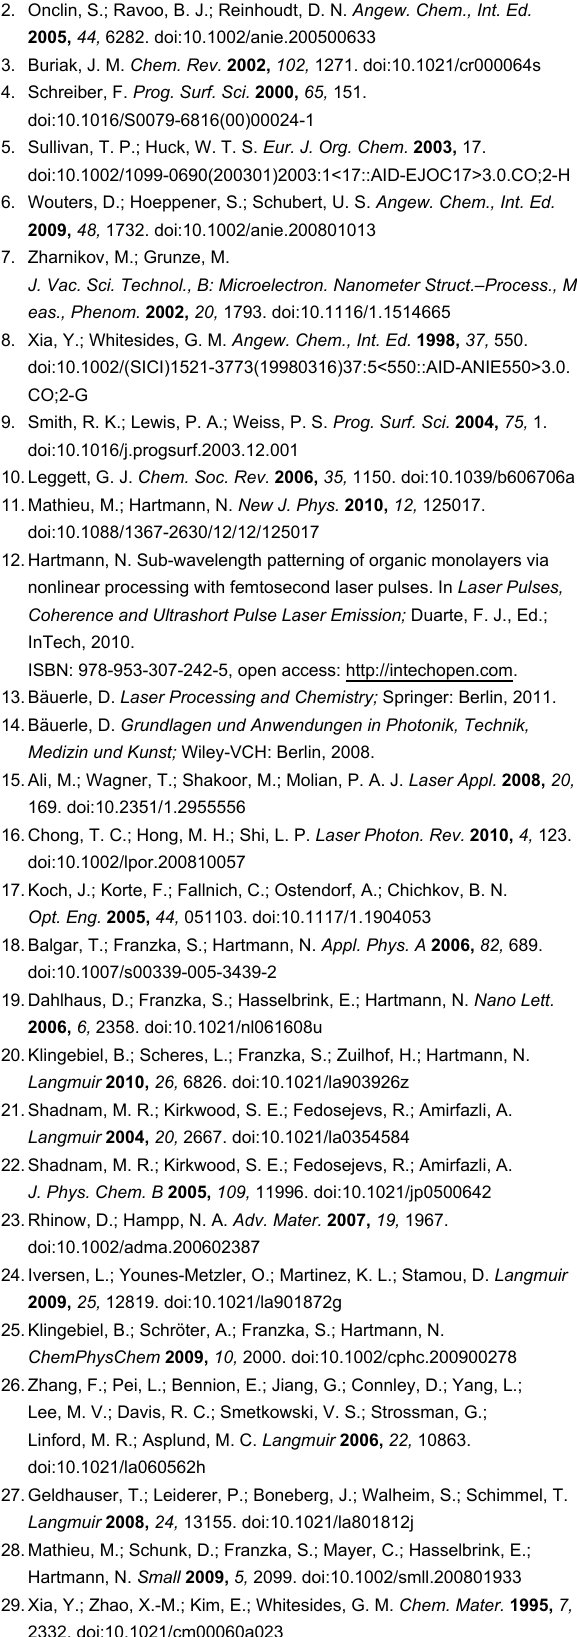
measured with an OEG SURFTENS universal